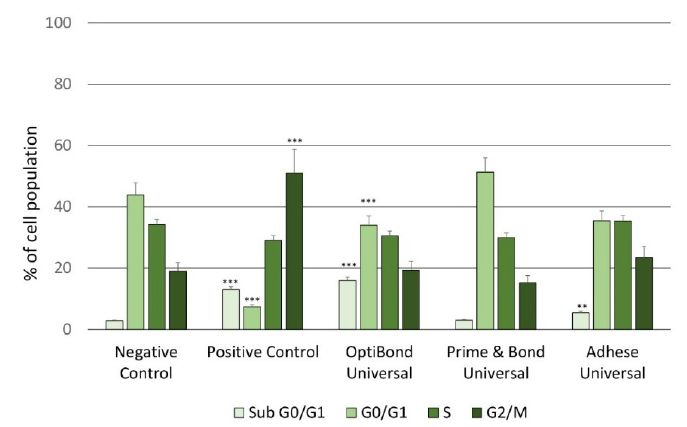
Figure 4. Flow cytometry (FC) analysis of cell cycle progression. ( a ) negative control; ( b ) positive control; ( c ) OptiBond Universal; ( d ) Prime&Bond Universal; ( e ) Adhese Universal. ** p < 0.01, *** p < 0.001 versus negative control.